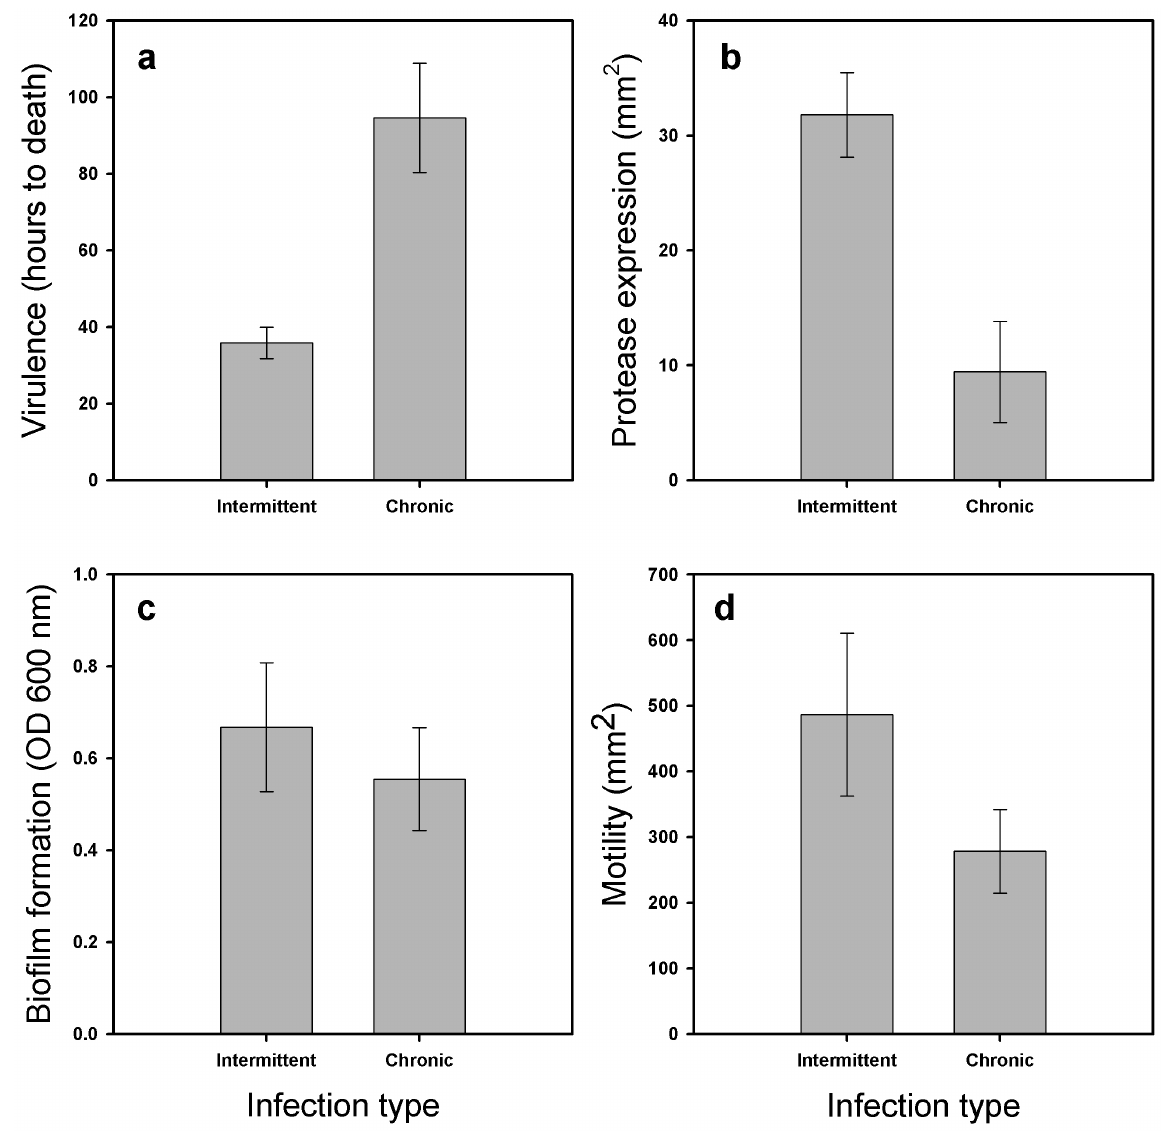
Figure 2. Bacterial trait measurements. Bacterial virulence measured in vivo for patients with intermittent colonisation or chronic CF-lung infection (a): virulence is defined as less hours to larval death, more virulent the bacterial strain. Panel (b) shows difference in bacterial protease expression, panel (c) difference in biofilm formation and panel (d) difference in motility for patients suffering from intermittent colonisation or chronic CF-lung infection. Error bars denote 6 1 SEM.